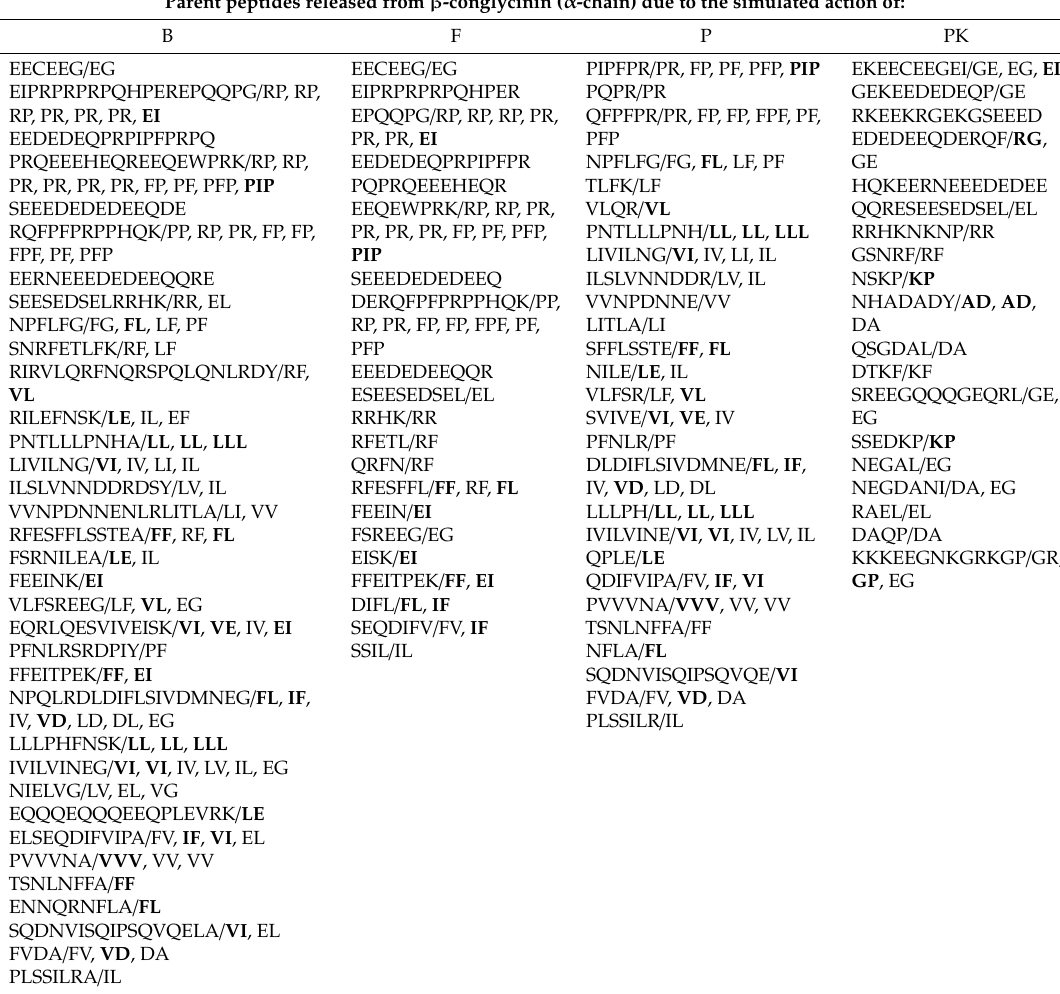
Parent peptides released from β -conglycinin ( α -chain) due to the simulated action of: B F P